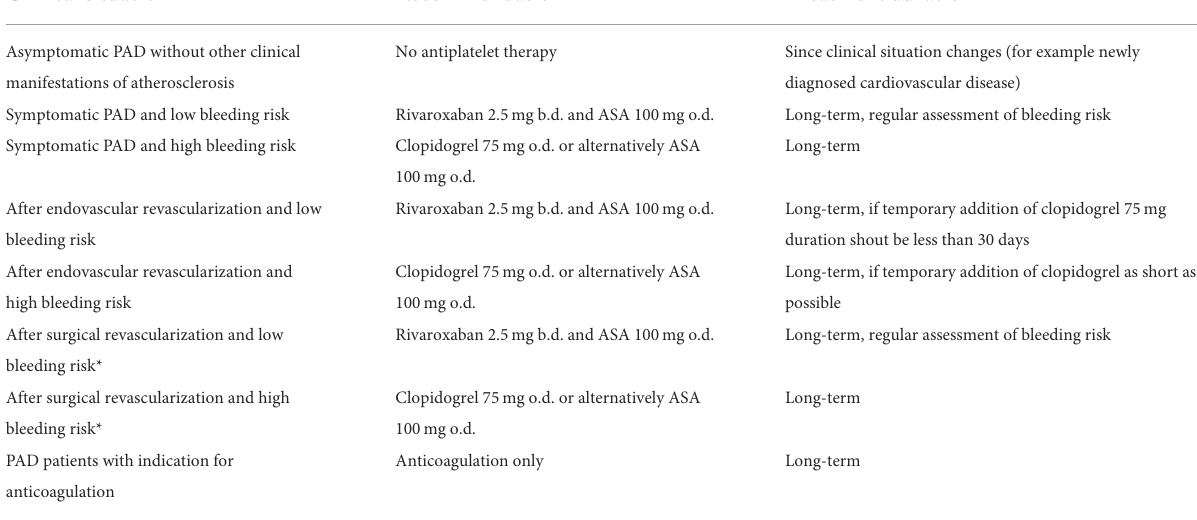
TABLE 2 Guideline recommendations [according to (2, 26,